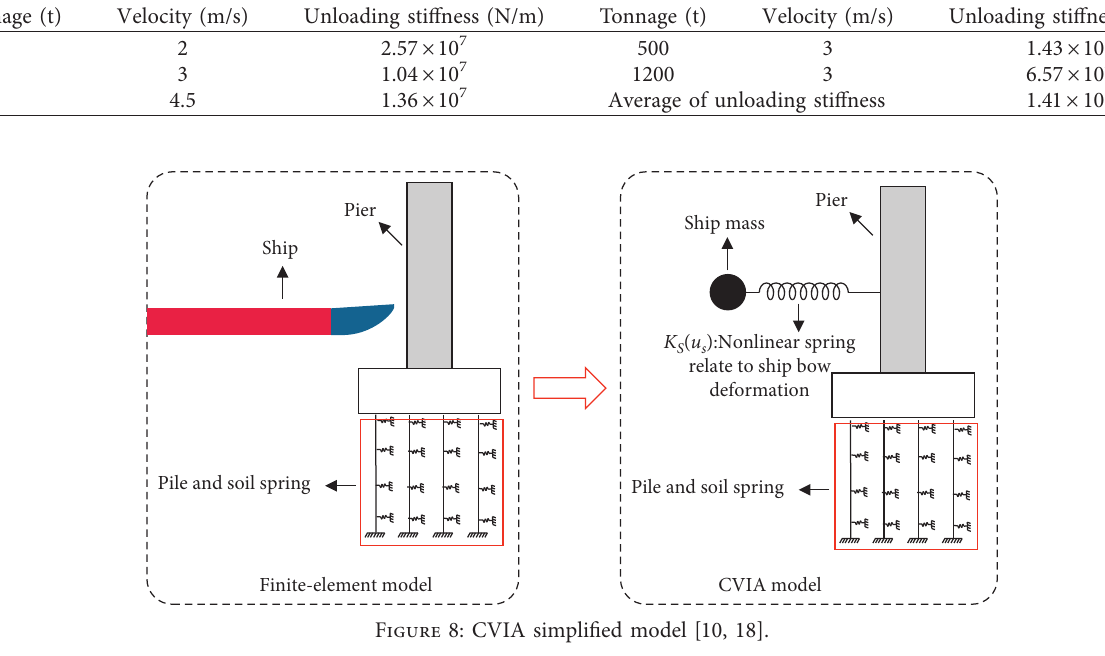
Figure 8: CVIA simplified model [10, 18].